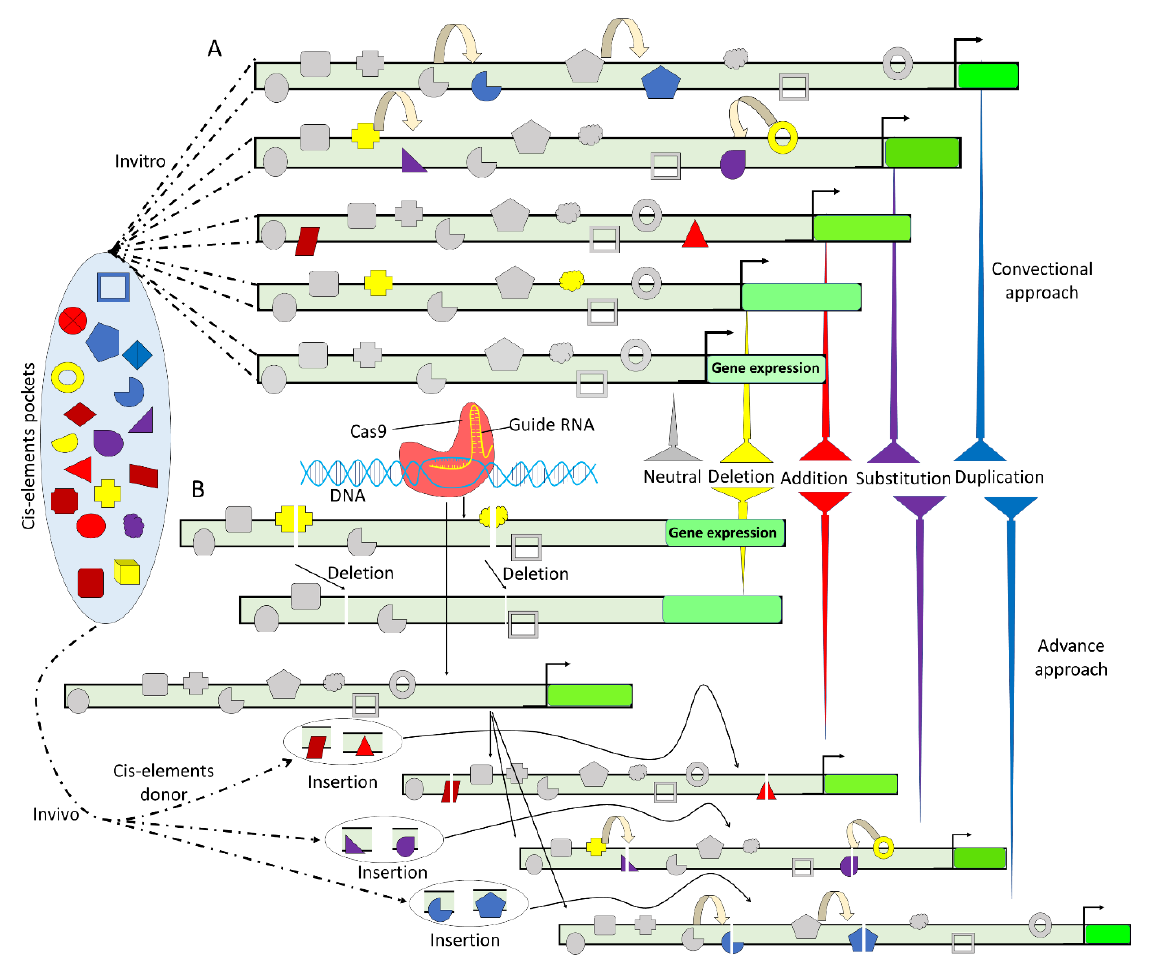
Figure 3. Approaches for generating synthetic promoters employing conventional and advanced technology. ( A ) In vitro assembly of desired Cis- elements from the Cis- elements pockets over the proximal promoter through deletion (yellow), addition (red), substitution (purple), and duplication (sky blue). The basal level of selected promoter expression is shown as neutral (gray). ( B ) CRISPR- mediated targeted knock of the core nucleotide from Cis- elements through deletion (gray) and knock-in of the same or different Cis- elements through addition (red), substitution (purple), and duplication (sky blue) in vivo. Alteration in the Cis- elements distribution over the proximal region of synthetic promoter changes the gene expression pattern.